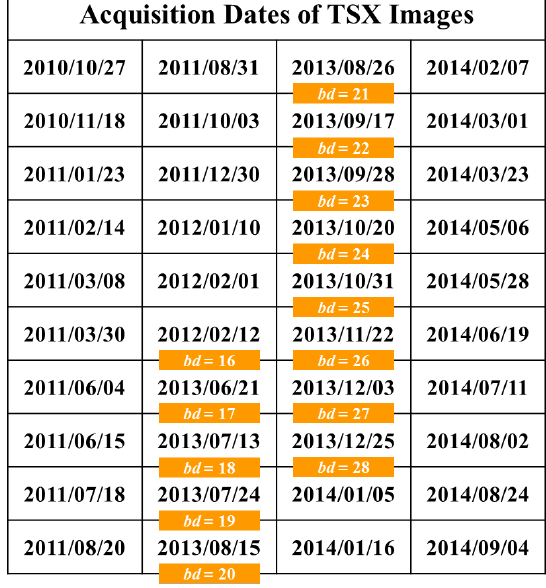
Table 1. TerraSAR-X images and break date ( bd ) setting.